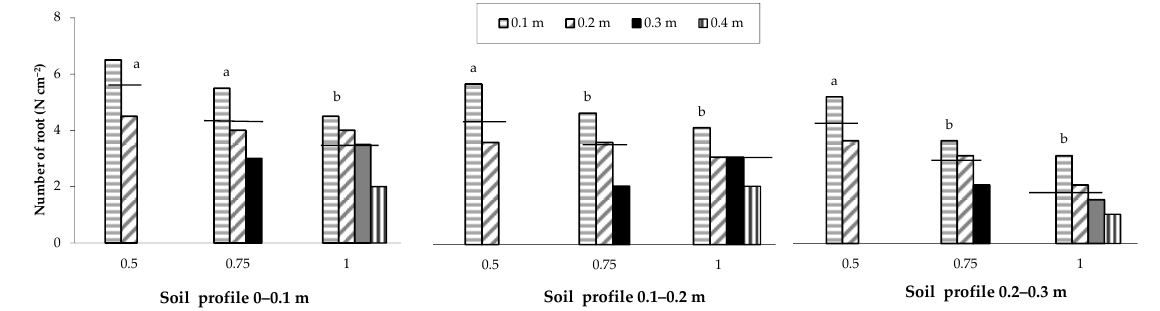
Figure 6. Spatial distribution of the maize root number as influenced by the change in row spacing (0.5, 0.75 and 1 m), soil profile and distance from the row (0.1, 0.2, 0.3 and 0.4 m). The horizontal lines over the bars represent the mean values of the groups. The group means with the same letter within each soil profile are not significantly different (SNK test at p = 0.05).